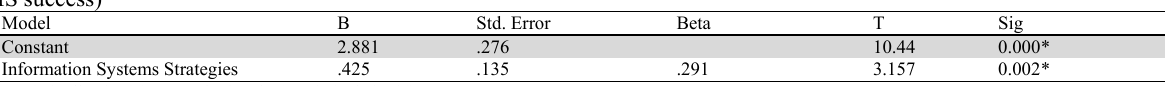
The coefficients for simple linear regression between mediating variable (strategic HR systems) and the dependent variable (IS success)